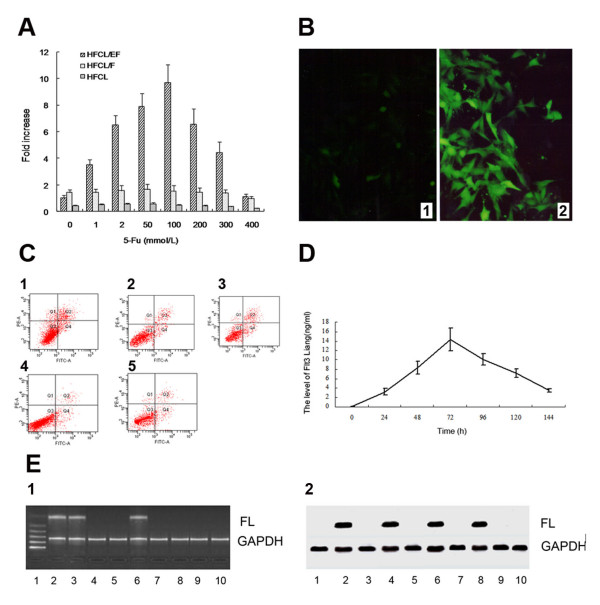
A: Induced expression of EGFP in HFCL cells transfected with Egr-EF after exposure to 5-FU. EGFP expression in HFCL/EF cells transfected with Egr-EF was used to evaluate activation of the Egr-1 promoter by 5-FU treatment. EGFP expression in HFCL/EF cells exposed to 1, 2, 50, 100, 200, 300 mmol/L 5-FU was significantly higher than that in HFCL/EF cells not exposed to 5-FU and the HFCL group, P < 0.01. However, at 400 mmol/L 5-FU, there was no difference between the 5-FU treated group and the untreated group. Data are reported as mean ± SEM: B: EGFP expression confirmed by fluorescence inverse microscopy. (1) HFCL/EF group × 400. (2) HFCL/EF + 5-FU group × 400. C: Effect of supernatant from HFCL/EF cells treated with 5-FU on CD34+ cells. (1) HFCL/EF + 5-FU, (2) HFCL/EF, (3) HFCL/F + 5-FU, (4) HFCL/pCI + 5-FU, (5) HFCL + 5-FU. D: FL expression by HFCL/EF cells after Egr-1 promoter activation with 5-FU. FL production by HFCL/EF cells exposed to 5-FU (100 mmol/L) was measured using ELISA assay. Significant increases in FL protein levels were detected 24, 48, 72, 96, 120 and 144 h after exposure to 5-FU (P < 0.01, versus FL protein level at 0 h). Data are reported as mean ± SEM. E: (1)RT-PCR analysis of FL mRNA levels in HFCL/EF cells after 5-FU treatment. 1. 1.DNA Marker 11, 2.HFCL/EF with 5-Fu treatment group (in vitro), 3.HFCL/F without 5-Fu treatment group(in vitro), 4.HFCL/EF without 5-Fu treatment group(in vitro), 5.HFCL with 5-Fu treatment group (in vitro), 6.HFCL/EF plus 5-Fu group (in vivo), 7.HFCL/EF plus NS group(in vivo), 8. HFCL plus 5-Fu group (in vivo), 9. HFCL plus NS group(in vivo), 10. HFCL/pCI with 5-Fu treatment group (in vitro). (2) Western blot analysis of FL protein levels in HFCL/EF cells after 5-FU treatment. 1. 1. HFCL/EF without 5-Fu treatment group (in vitro), 2. HFCL/EF with 5-Fu treatment group (in vitro), 3. HFCL/pCI with 5-Fu treatment group (in vitro), 4. HFCL/F with 5-Fu treatment group (in vitro), 5. HFCL with 5-Fu treatment group (in vitro), 6. HFCL/F without 5-Fu treatment group (in vitro), 7. HFCL/EF plus NS group(in vivo), 8. HFCL/EF plus 5-Fu group(in vivo), 9. HFCL plus 5-Fu group(in vivo), 10. HFCL plus NS group(in vivo), Lain 2. the consistent expression of GAPDH in various groups.